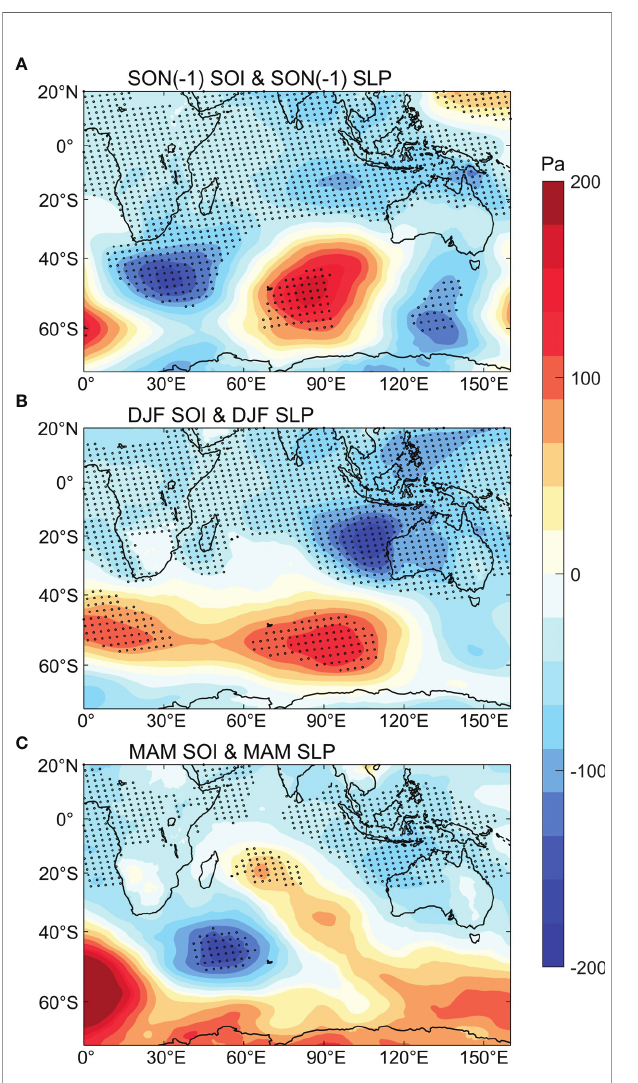
FIGURE 8 | Regression coef fi cients of SLP anomalies on the (A) normalized SON-averaged (-1) SOI, (B) normalized DJF-averaged SOI and (C) normalized MAM-averaged SOI. Results signi fi cant at the 95% signi fi cance level are stippled.